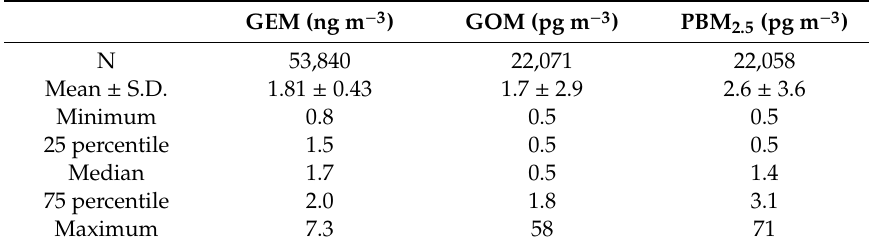
Table 1. Mean ± standard deviation (SD), median, minimum and maximum concentrations of GEM, GOM, and PBM 2.5 at Cape Hedo in the entire period from October 2007 to December 2018. GEM (ng m − 3 ) GOM (pg m − 3 )